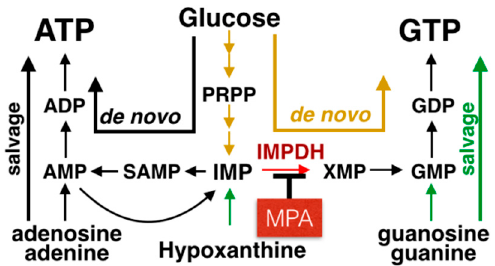
Figure 2. MPA: Mechanism of Action. IMPDH catalyzes the rate-limiting, NAD-dependent oxidation of inosine monophosphate (IMP) to xanthosine 5 ′ -monophosphate (XMP), which is an intermediate metabolite in the production of guanosine-triphosphate (GTP). MPA is a potent, selective, reversible, and noncompetitive inhibitor of IMPDH. Abbreviations: SAMP: succinyl-AMP, and PRPP: phosphoribosyl pyrophosphate.